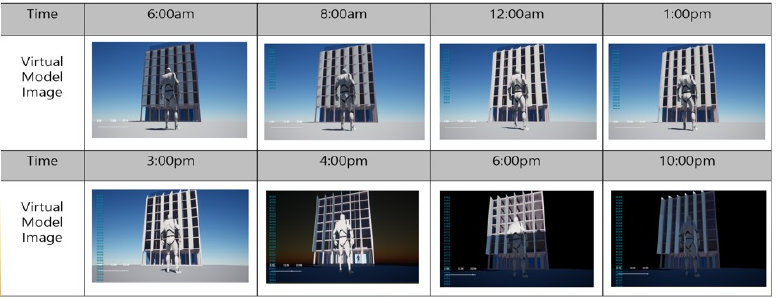
Figure 16. Virtual Reality Model Reflecting Changes in Motion in Relation to Daylight at Different Times of the Day.